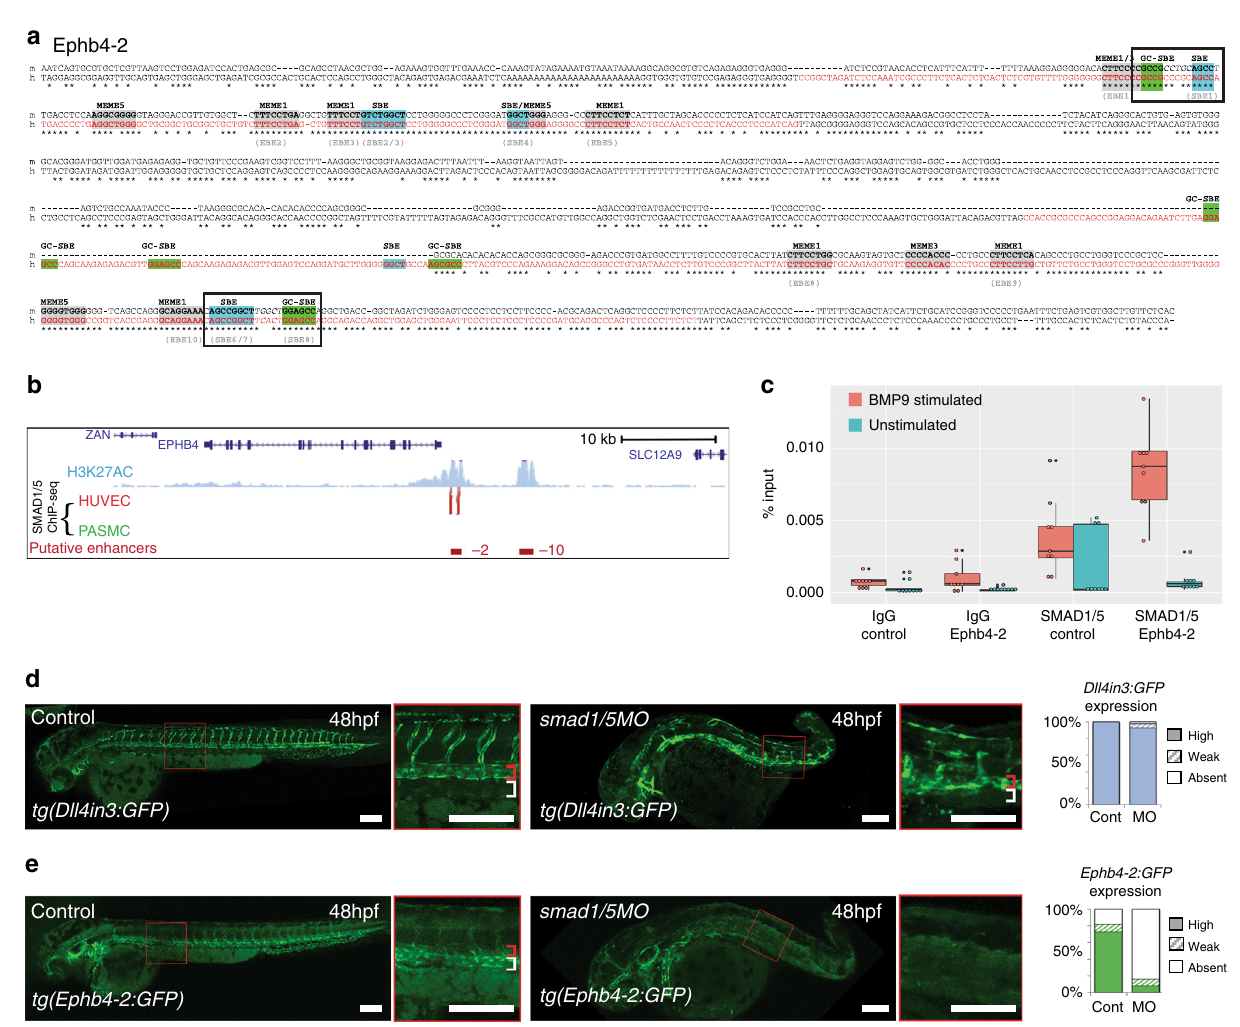
Fig. 6 The Ephb4-2 enhancer is bound by SMAD1/5. a Mouse (m) and orthologous human (h) DNA sequence of the Ephb4-2 enhancer. Red nt on human sequence correspond to regions bound by SMAD1/5 as determined from SMAD1/5 human umbilical vein endothelial cell (HUVEC) chromatin immunoprecipitation-sequencing (ChIP-seq) data 32 (see also Supplementary Fig. 6c). Green boxes denote GC-SBE motifs associated with SMAD1/5 binding, blue boxes denote SBE motifs associated with all SMAD binding and grey boxes denote other over-represented motifs (MEME1, 3 and 5 32 ). Black outlined boxes denote composite SBE/GC-SBE elements, italic nt indicate linker sequences. Grey text under sequences indicates motifs previously identi fi ed as the EBEs and SBEs in earlier analysis (Supplementary Fig. 4). For sequence logos of motifs, see Supplementary Fig. 6b. b SMAD1/5